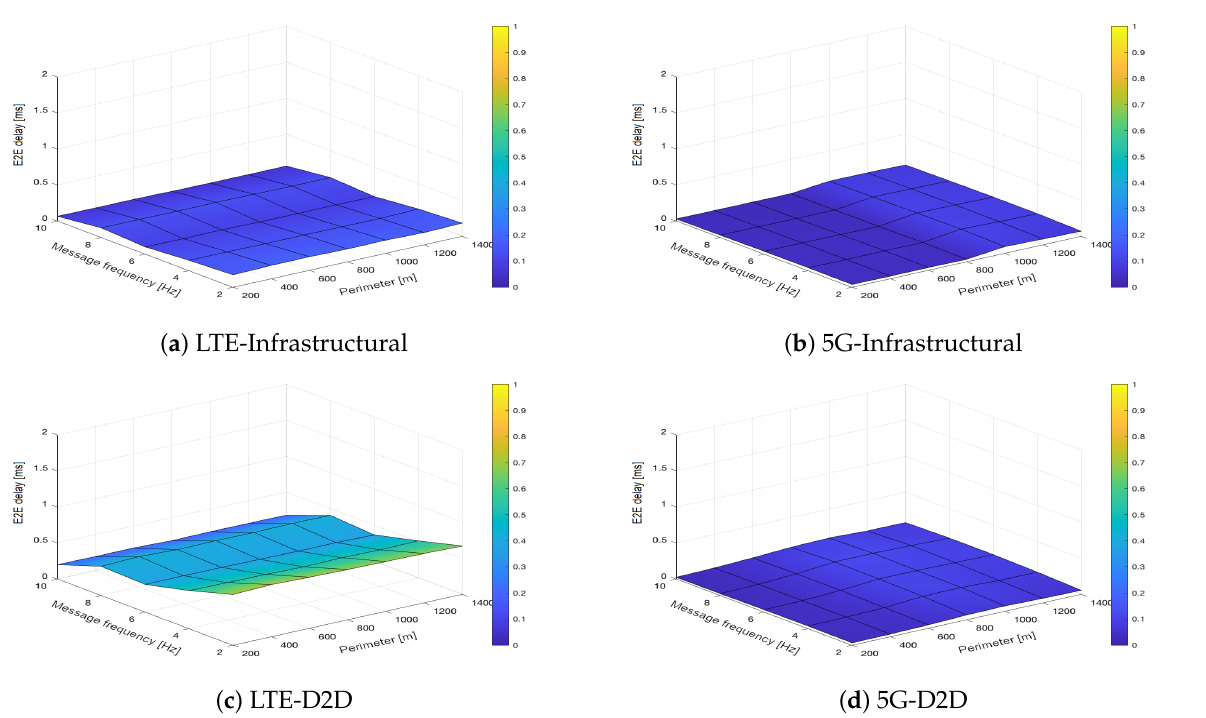
Figure 8. End-to-End (E2E) latency simulated for all the investigated modes of the 4G-based and 5G-based C-V2X technologies and traffic intensity of 250 vehicles per hour.